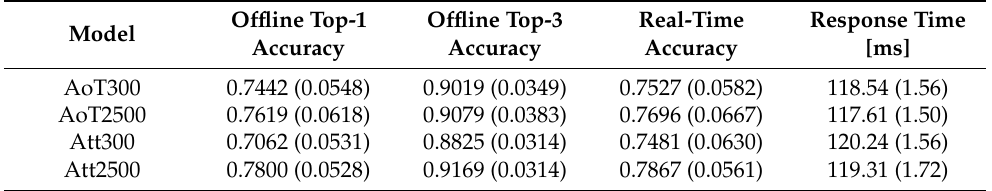
Table 4. Offline and real-time results in terms of classification accuracy when training is performed using a sliding windows of 200 ms. The table shows the average across subjects and the standard deviation in